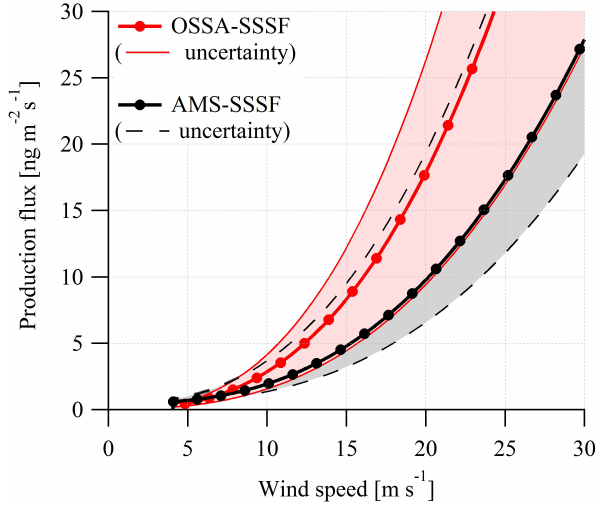
Fig. 5. Size dependent SSSF at two different Re H ( ∼ 10ms − 1 ) and black at 2.2 × 10 6 ( ∼ 15ms − 1 ). Markers repre- sent the real data measured at certain wind speed; lines represent calculations from the OSSA source function. Shaded areas repre- sent the SSSF uncertainties.